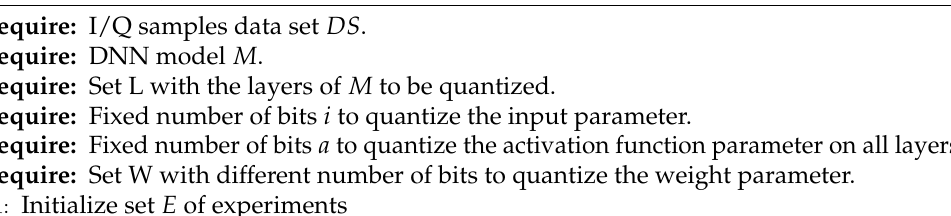
Algorithm 2 Stage 2: Layered evaluation for